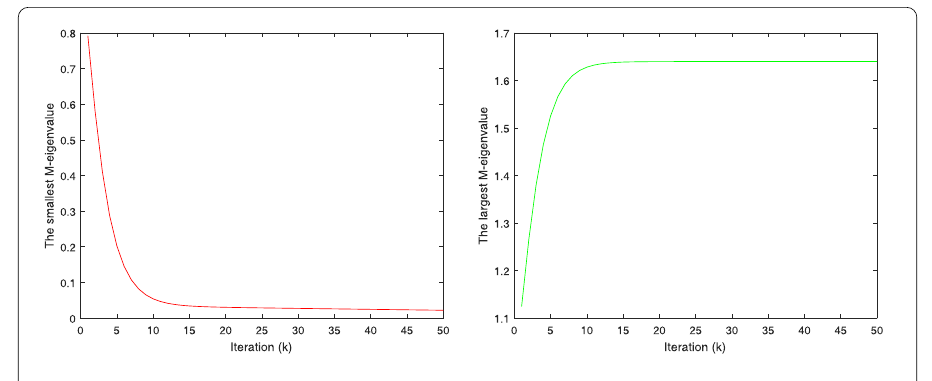
Figure 1 Numerical result of Example 4.1